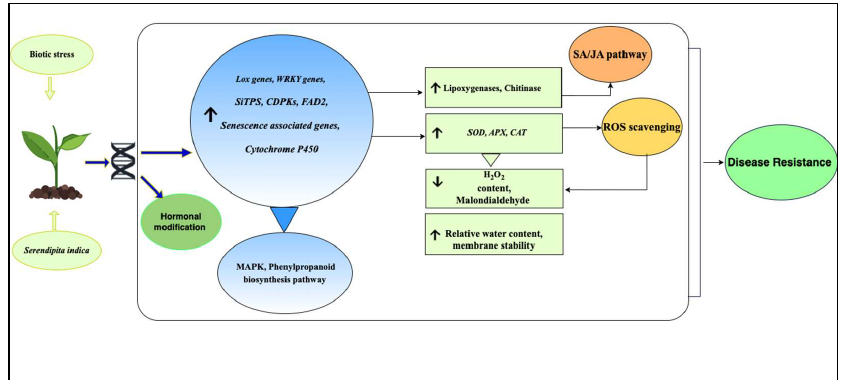
Figure 6. Schematic representation of the effects of S. indica on plants under biotic stresses. S. indica maintains the plant growth and development throughout the growing stages by regulating various genes and antioxidant production, leading to the development of tolerance against stresses in host plants. Various genes are involved in the process consisting of FAD2 —fatty acid desaturase 2, LOX lipoxygenase, SiTPs —terpenoid synthase gene, senescence associated genes, WRKY — transcription factor. Upward and downward arrows represent upregulation and downregulation of genes or processes, respectively.